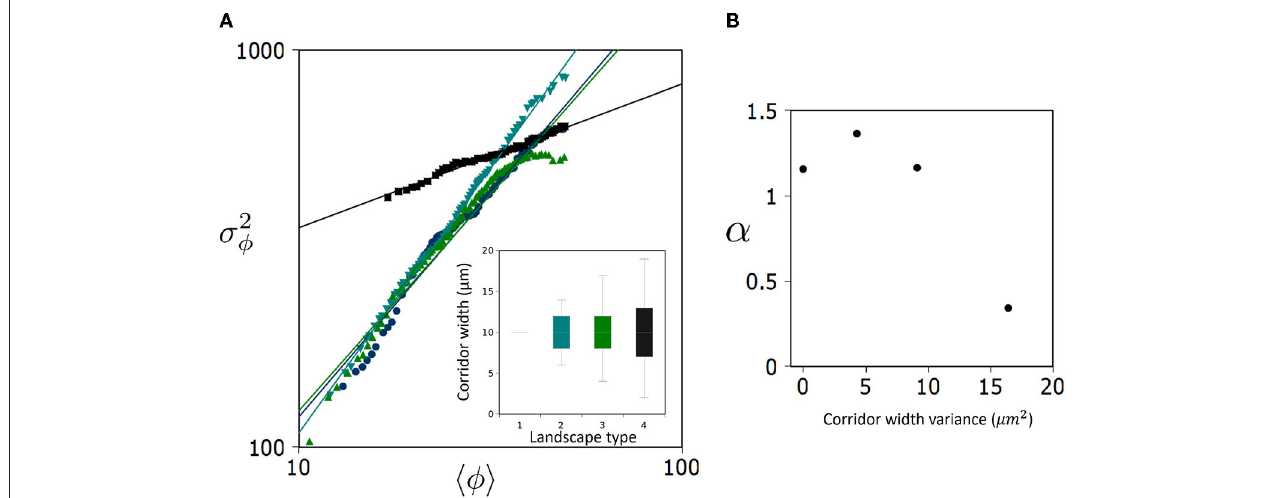
FIGURE 3 | Landscape dependency of Taylor’s Law in a bacterial metapopulation. (A) Log-log plot showing the relationship between the average occupancy of a patch, h φ i , and its variance, σ 2 φ , over ( n = 30) replicates and across all patches (85) generating the unique Taylor’s Law (TL) for each landscape type. Inset displays a box plot of corridor widths around the mean (10 µ m). Four variances were used in this study, ( σ 2 = 0,4,9,16 µ m 2 ). (B) The slope of TL, α , is plotted against the variance of corridor width (randomness) defining landscape types. on solid LB agar plates (LB Broth EZMix, Sigma-Aldrich +